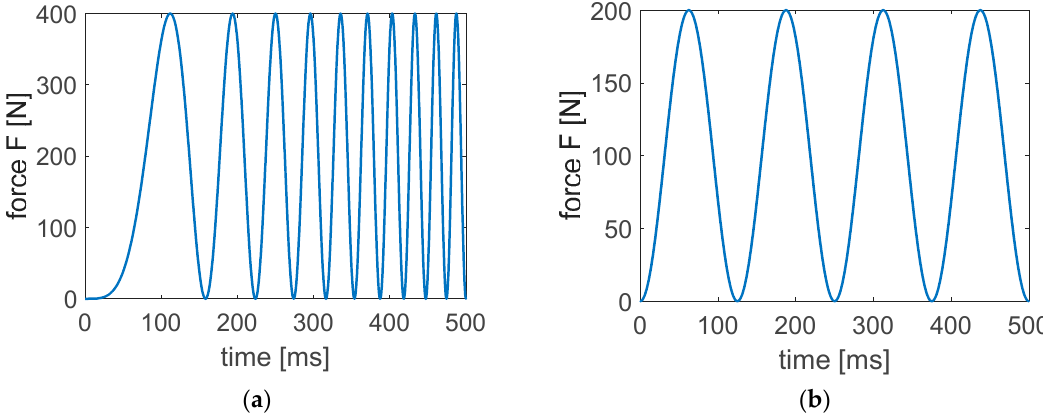
Figure 7. Time course of force F : ( a ) load case 1, ( b ) load case 2.